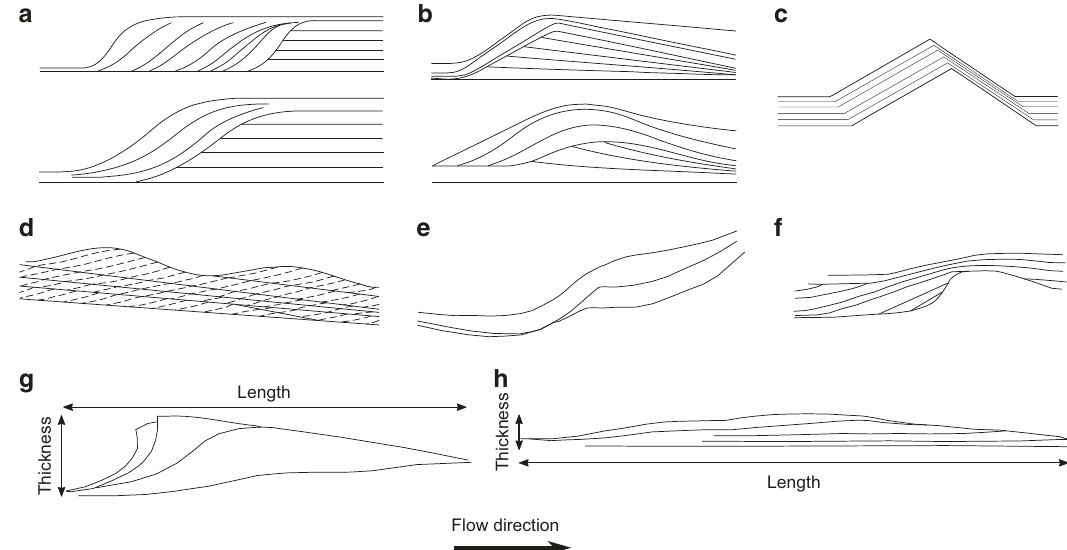
Fig. 1 Sketches of backset bedforms in PDC and fl uvial deposits. a Chute-and-pool structures in dilute PDC deposits at Laacher See 20 . b Antidunes in dilute PDC deposits at Laacher See 20 . c Regressive dune bedform 22 . d Stable antidunes 30 . e Regressive bedform from the Proximal Bedded Deposits at Mt St Helens 39 . f Fluvial chute-and-pool structure 75 . g Steep backset bedform as described in this paper, showing length and thickness de fi nitions. h Shallow backset bedform, as described in this